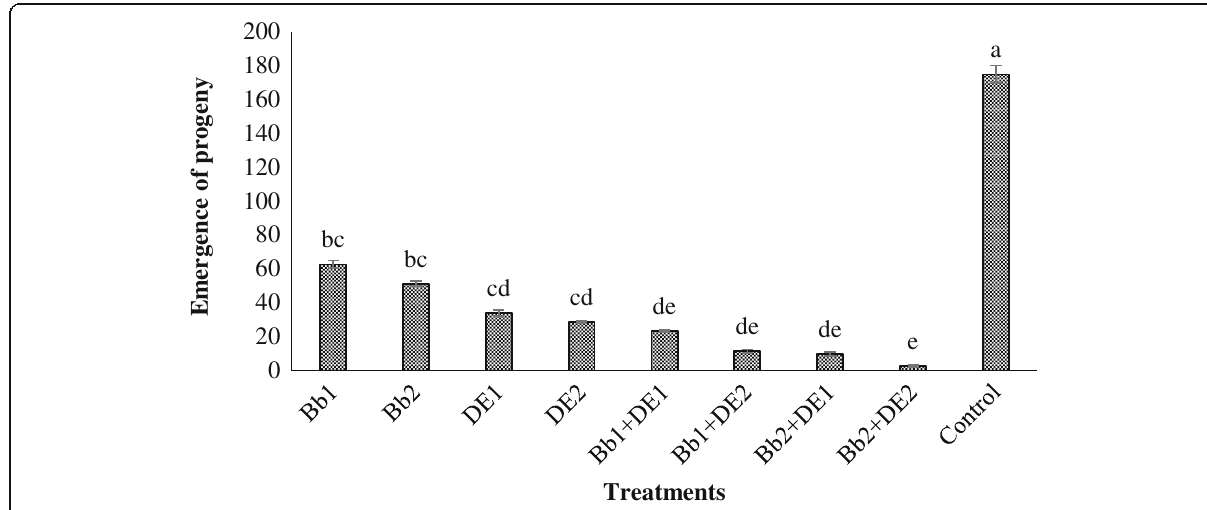
Fig. 3 Progeny production (mean± SE, n = 3) of Tribolium castaneum treated with two concentrations of Beauveria bassiana (1 × 10 6 and 1 × 10 8 conidiakg − 1 of wheat) and DE (200 and 400 ppm) (alone and in